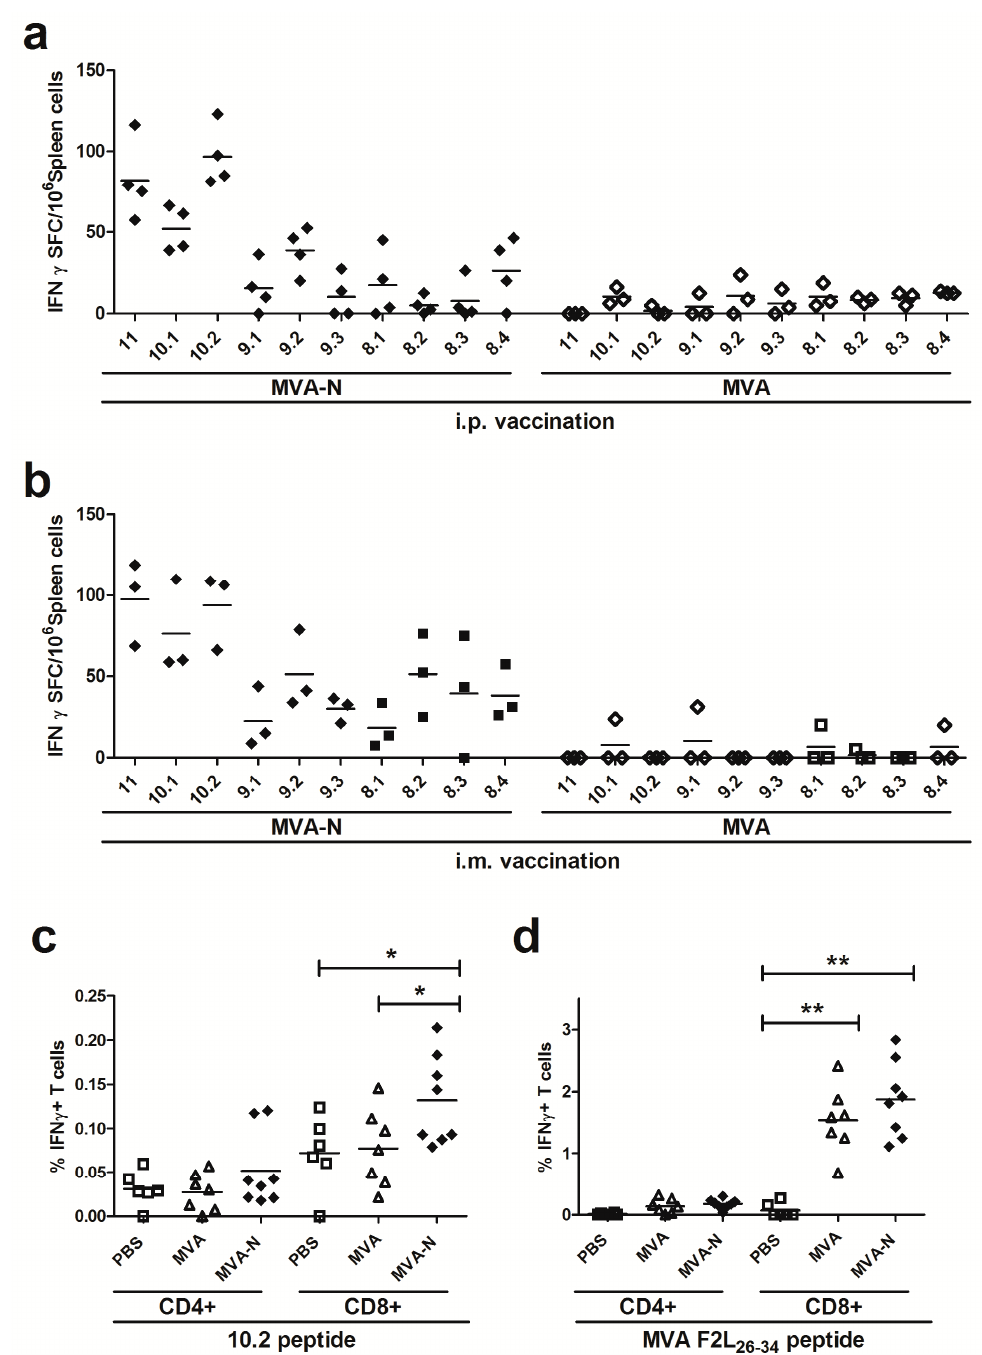
Figure 5. Identification of an H2-d restricted T cell epitope in MERS-CoV N protein; ( a–d ) Groups of BALB/c mice ( n = 3 to 8) were vaccinated in a prime-boost regime with 10 8 PFU of MVA-MERS-N via i.p. ( a ) or i.m. ( b–d ) application. Mice immunized with non-recombinant MVA (MVA) and PBS served as negative controls. ( a-b ) Splenocytes were stimulated with individual 8-11-mer peptides and IFN- γ spot-forming CD8+ T cells (IFN- γ SFC) were measured by ELISPOT. ( c–d ) Splenocytes were stimulated with positive MERS-CoV N 10.2 peptide ( c ) or F2L 26-34 peptide ( d ) and IFN- γ producing CD8+ or CD4+ T cells were measured using intracellular cytokine staining assay and FACS analysis. The lines represent means. *< 0.05, **< 0.005.